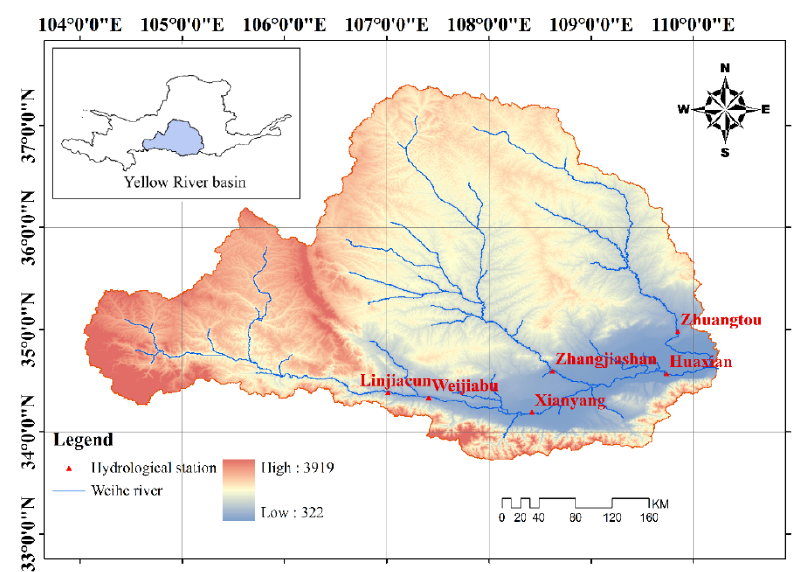
Figure 1. Locations of hydrological stations in the WRB.